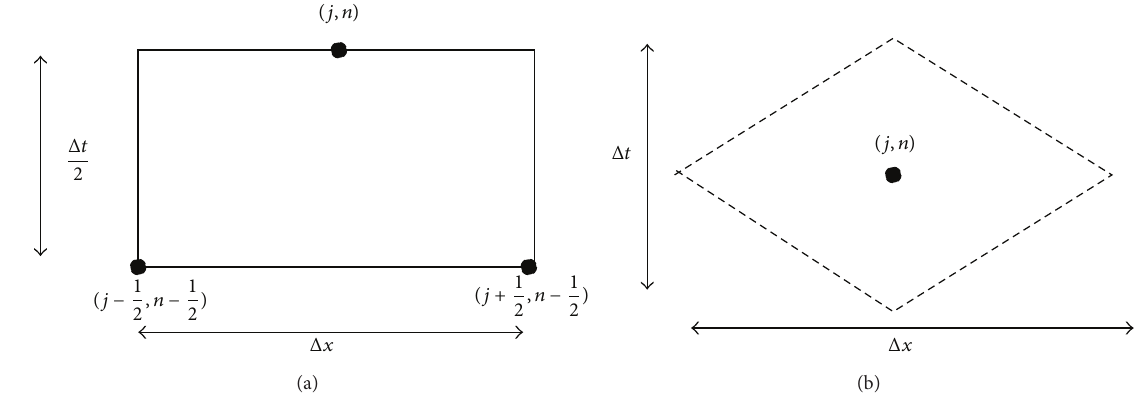
Figure 2: The graphic to the left shows a conservation element CE (𝑗, 𝑛) and the graphic to the right shows the associated solution element SE (𝑗, 𝑛) .